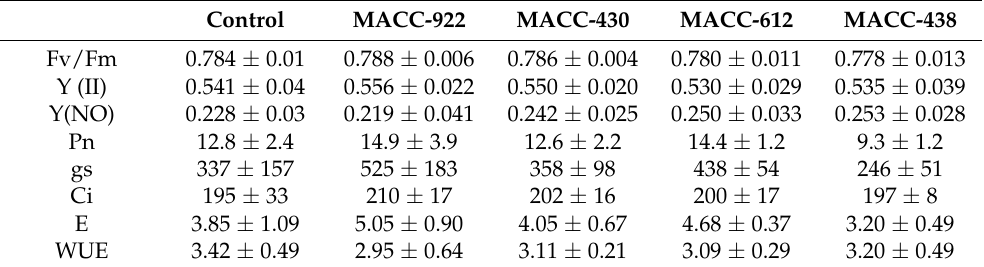
Table 3. Chlorophyll- a fluorescence induction and gas exchange parameters in the control and the alga-treated Mv B é res wheat plants 28 days after spraying. Pn: net photosynthesis ( µ mol m − 2 s − 1 ); gs: stomatal conductivity (mmol m − 2 s − 1 ); Ci: intercellular CO 2 concentration ( µ mol CO 2 mol − 1 );